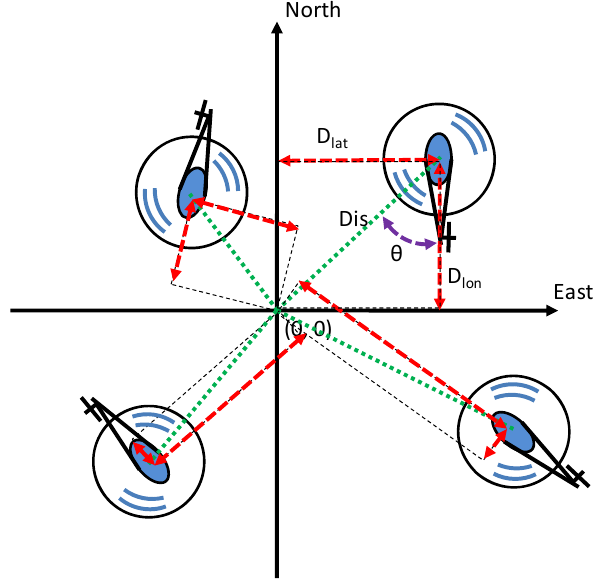
Figure 11. The concept diagram of (7). Dis is transformed into D this equation.